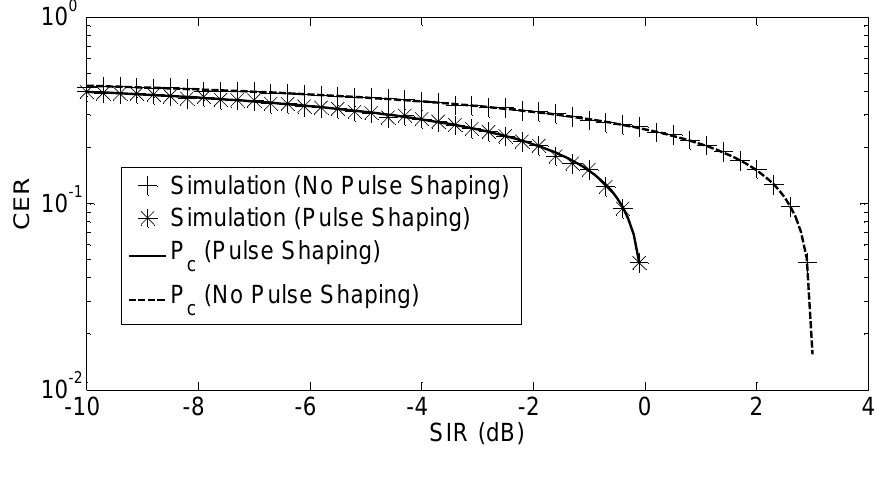
Figure 4. Chip error rate: the case of coherent O-QPSK demodulation. CER, chip error rate; SIR, signal-to-interference ratio.